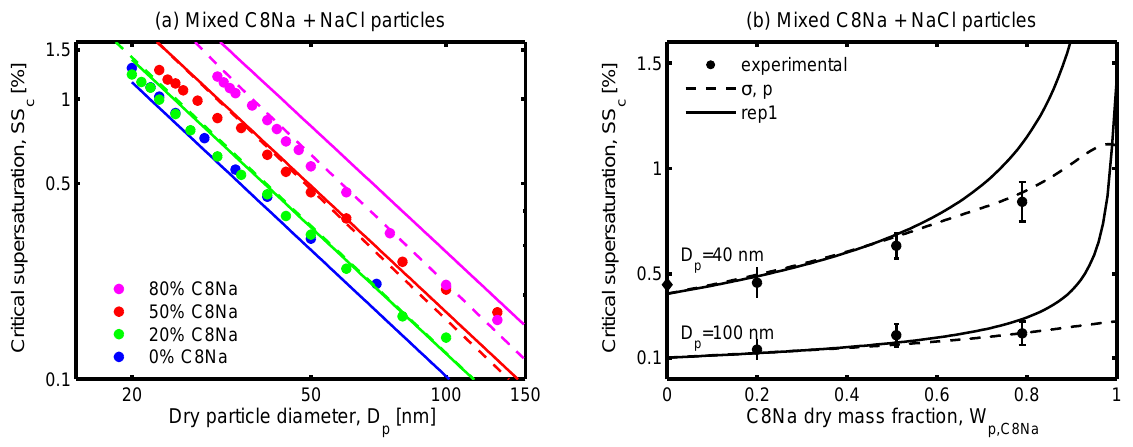
Fig. 2. Critical supersaturations ( SS c [%]) for particles comprising sodium octanoate (C8Na) mixed with sodium chloride (NaCl), as func- tions of (a) dry particle diameter ( D p [nm]), and (b) dry particle surfactant mass fraction ( W p , C8Na ). Results are shown for particles with selected dry surfactant mass fractions in panel (a), and for dry particle sizes of D p = 40nm (upper curves and data points) and D p = 100nm (lower curves and data points) in panel (b). In both figures, points are experimental values, dashed lines are calculated with the detailed ther- modynamic model ( σ, p), both adapted from Prisle et al. (2010), and solid lines are calculated with the simple organic representation (rep1).